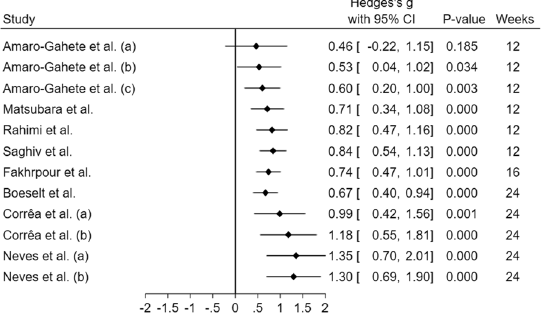
Figure 4. Cumulative forest plot from a random-effect meta-analysis shown as Hedges’ g with 95% CIs of the protocol duration increase on Klotho concentrations. For each study, the square represents the Hedges’ g of the intervention effect with the horizontal line intersecting it as the lower and upper limits of the 95%